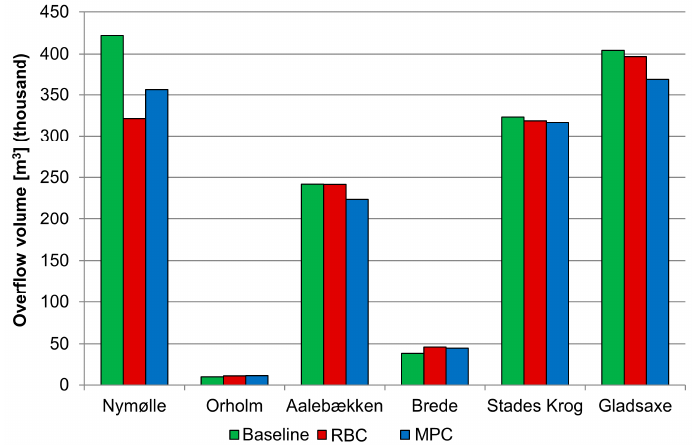
Figure 4. Distribution of the total overflow volume per environmental section for the three scenarios.